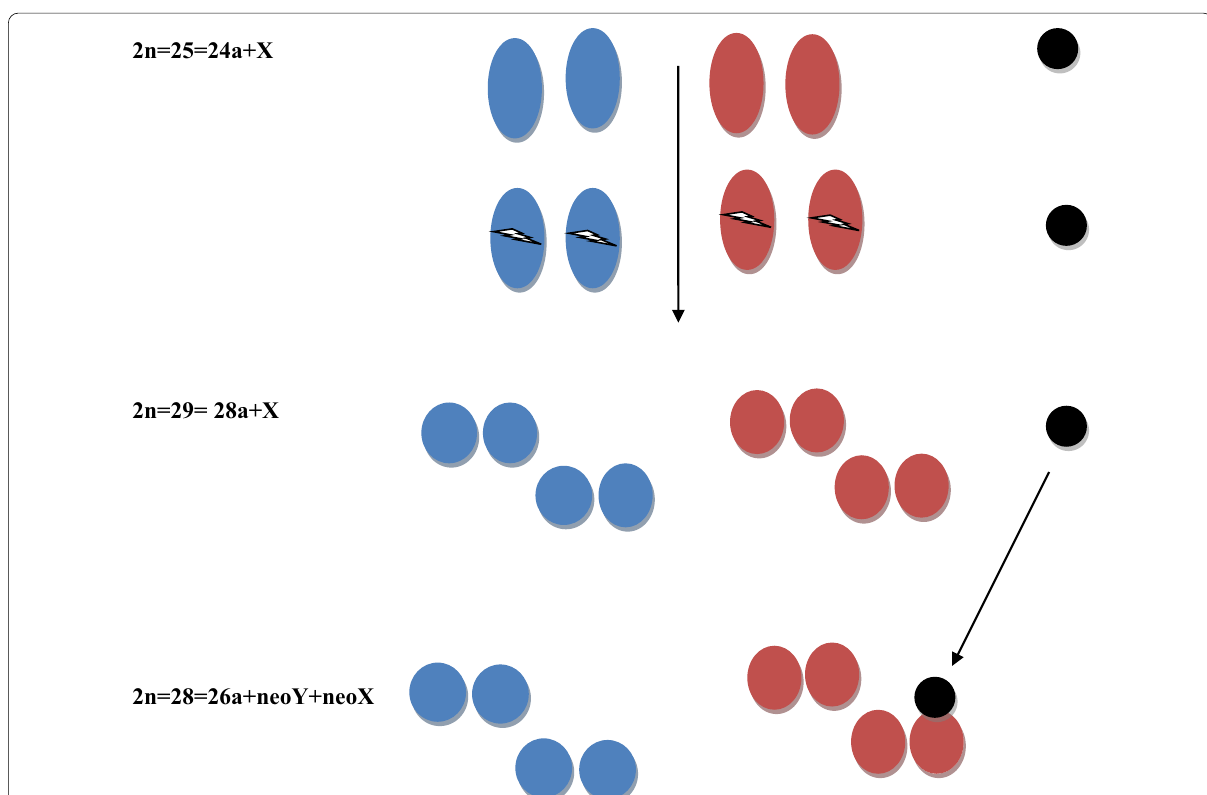
Fig. 2 Evolution of sex determination and numeric increase of the chromosome complement in Neurothemis tullia tullia (Kiauta, 1968a, 1968b, 1968c,